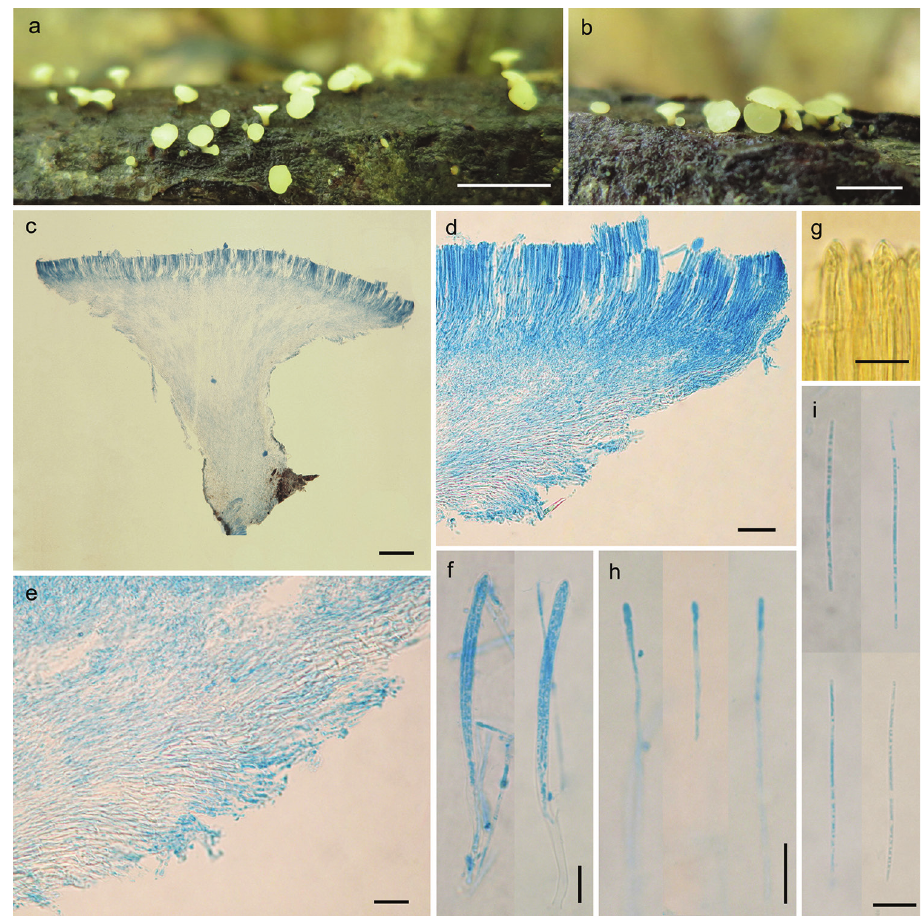
Figure 2. Chlorovibrissea korfii H.D. Zheng & W.Y. Zhuang (HMAS 275652, holotype). a, b Fresh apothecia on natural substrate c Longitudinal section of apothecium d Structure of margin, flank and hymenium e Excipular structure of flank f Asci g IKI reaction of apical rings h Paraphyses i Ascospores. Mouting media: c–f, h, i lactophenol cotton blue, g Lugol’s solution. Scale bars: a = 5.0 mm, b = 2.0